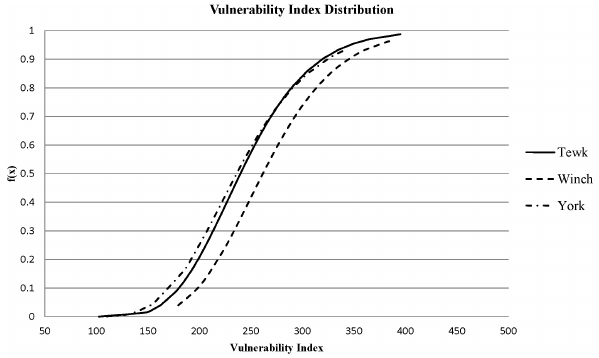
Fig. 9. Vulnerability index distribution.